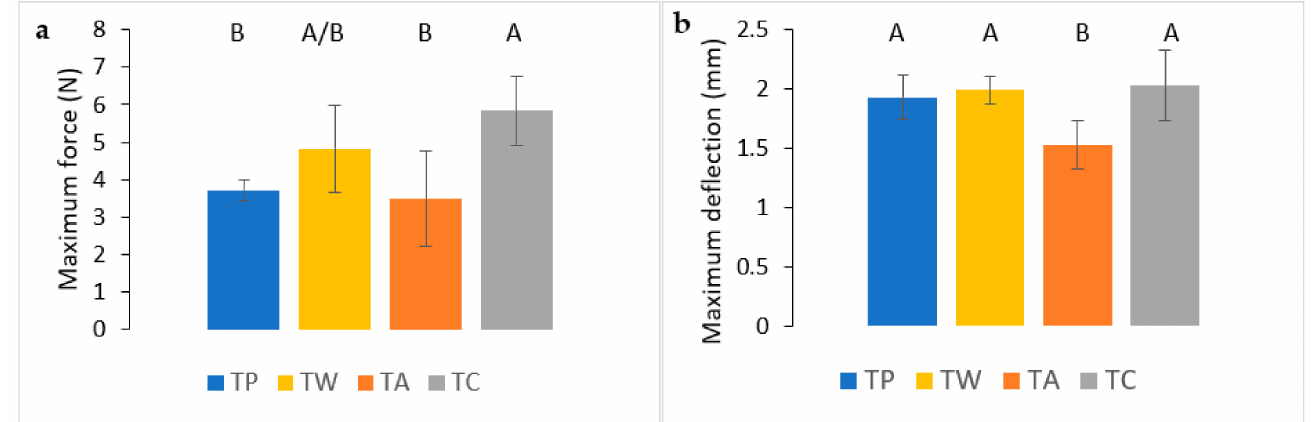
Figure 9. Maximum force ( a ) and maximum deflection ( b ) that tissues can sustain before breakage. Significance of standard deviation was investigated with a Tukey HSD post hoc test performed on 7 different specimens. On the top of each column, a letter was reported. Means that were identified as not significantly different were grouped under the same